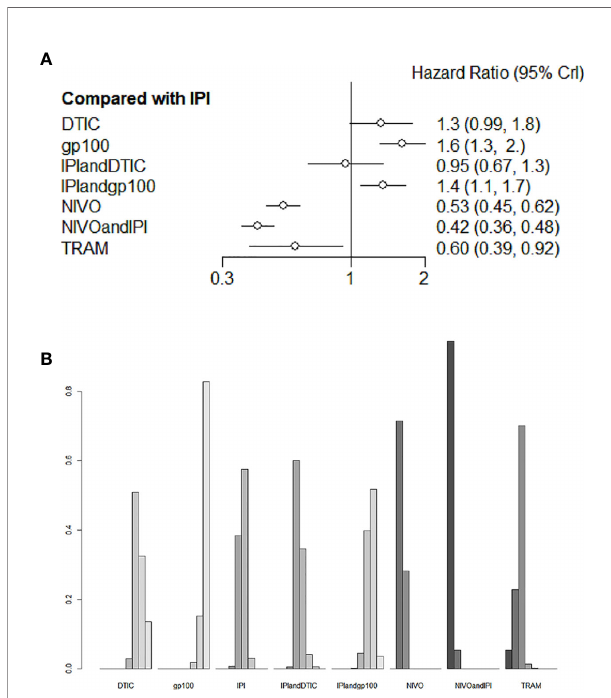
FIGURE 5 | Direct and indirect comparisons for PFS (A, B) among IPI+DTIC, IPI+gp100, DTIC, IPI, gp100, NIVO, NIVO+IPI, TRAM.